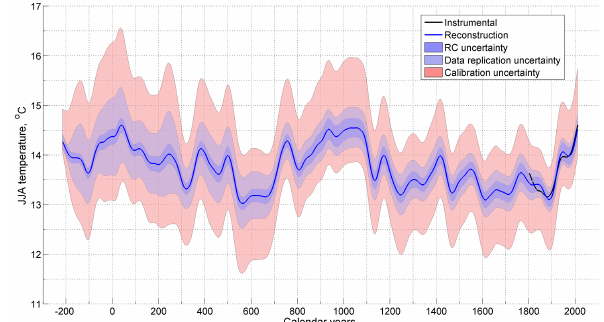
Figure 7. Reconstruction of JJA temperatures with 95% uncer- tainty intervals. See text for details. Values are smoothed with 100yr splines.